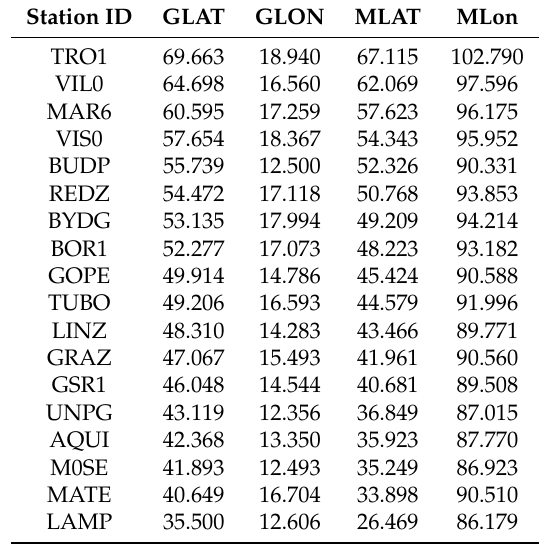
Table 1. Geographic and geomagnetic positions of the considered European stations (in degrees).